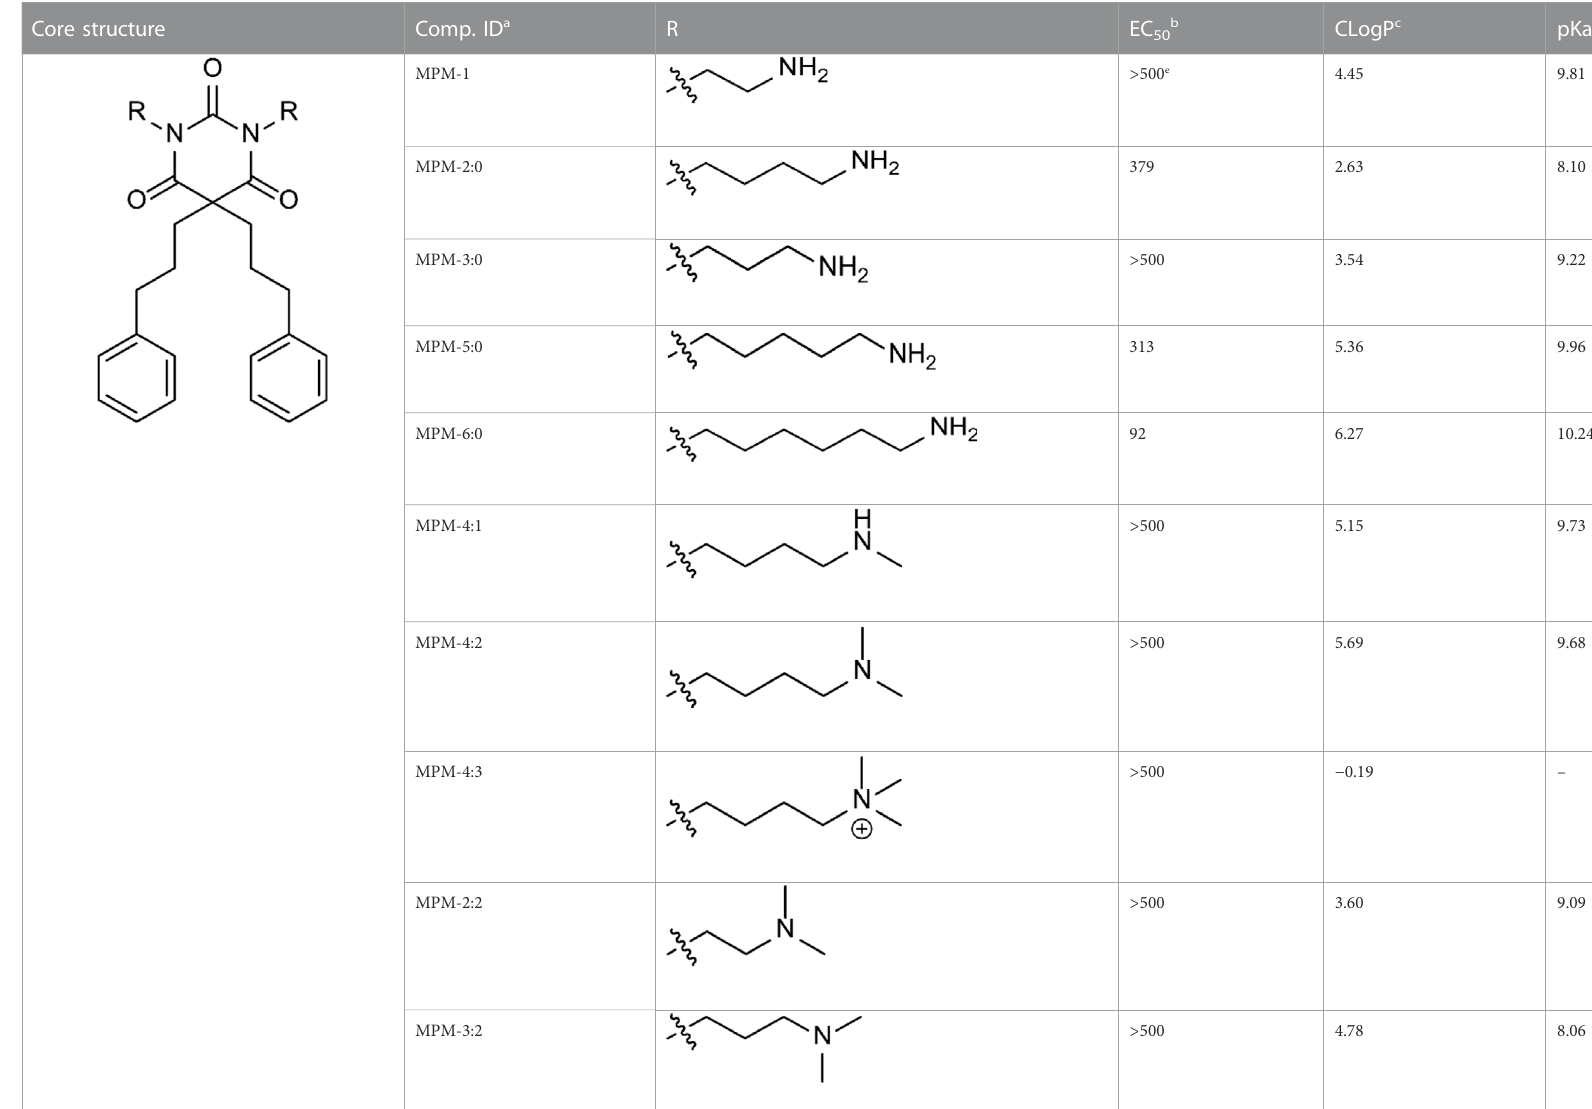
TABLE 1 Overview of the MPMs and their hemolytic activity against human red blood cells (expressed by the EC 50 values in µM), as well as their CLogP and pKa